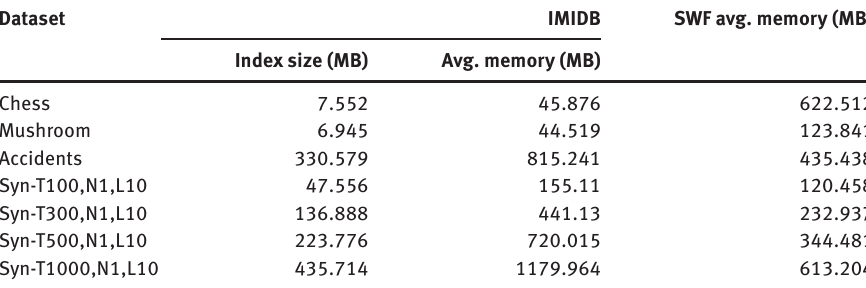
Table 12: Memory Usage Analysis. Dataset